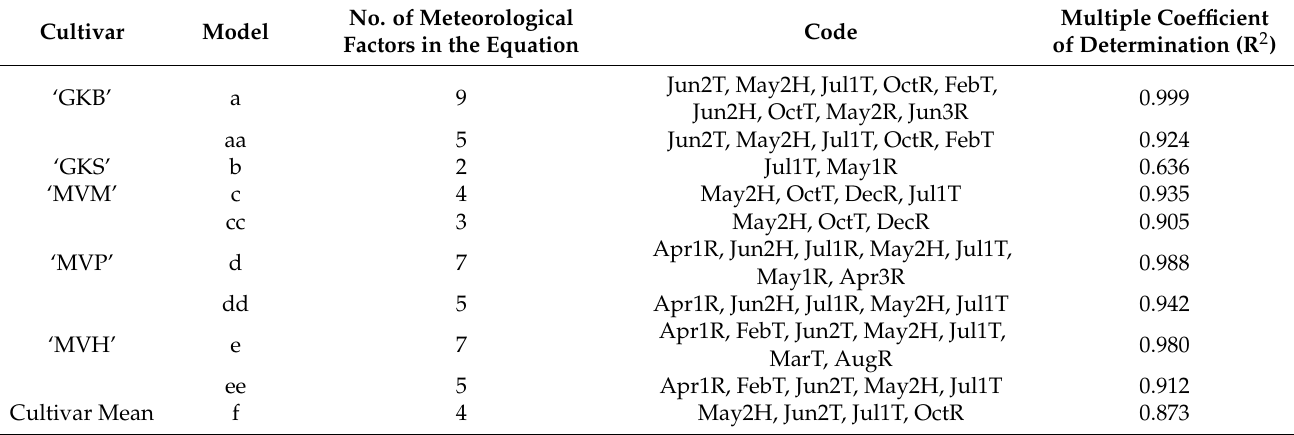
Table 4. Characteristics of the gluten index functions developed by stepwise